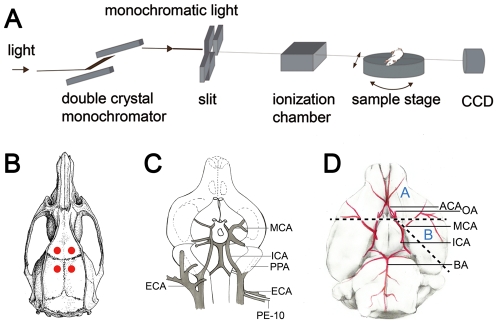
A schematic presentation of BL13W-Line Station of Shanghai Synchrotron Radiation Facility (A).The synchrotron beam is monochromatized and penetrated the animal on the sample stage, then received by a CCD camera. A picture (B) illustrates four burr holes on the calvarium used to measure surface CBF with laser Doppler flowmetry. A schematic drawing of catheterization with major blood vessels labeled (C). A PE-10 tube is inserted into ECA and advanced upon to the bifurcation of ECA and ICA. A Cartoon (D) illustrates the circle of Willis in a rat brain. Dotted lines indicate the locations of brain cut. Sample A is prepared for ACA and sample B is prepared for MCA. ACA: anterior cerebral artery, BA: basilar artery, CCA: common carotid artery, ECA: external carotid artery, ICA: internal carotid artery, MCA: middle cerebral artery, OA: olfactory artery, PPA: pterygopalatine artery.